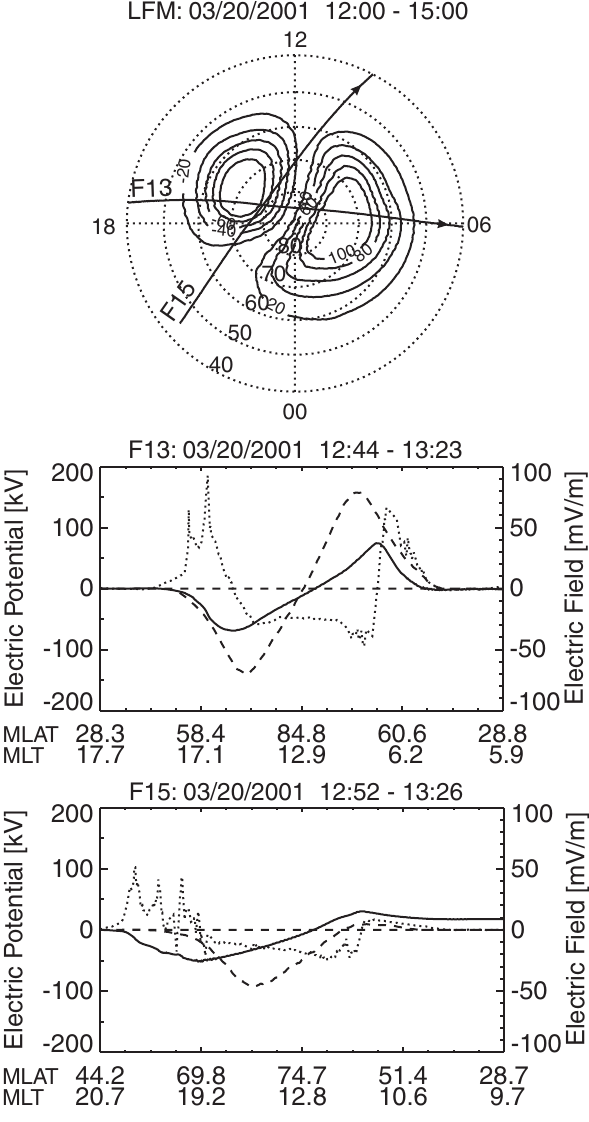
Fig. 14. Comparison of (a) the LFM electric potential distribu- tion with observations by (b) DMSP F13 and (c) DMSP F15 on 20 March 2001, 12:00–15:00UT. The line plots show the DMSP electric field (dotted line) and electric potential (solid line) and the LFM electric potential interpolated along the satellite